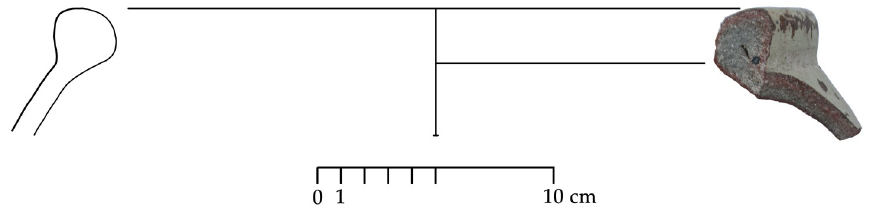
Fig 48. Rim of meat jar S/120631/4473 from Room